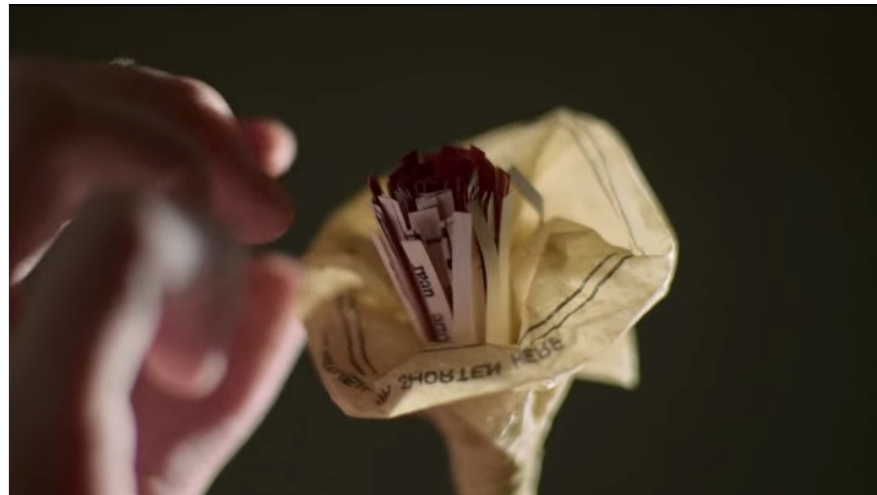
Figure 5. The Power of the Dog . Netflix.